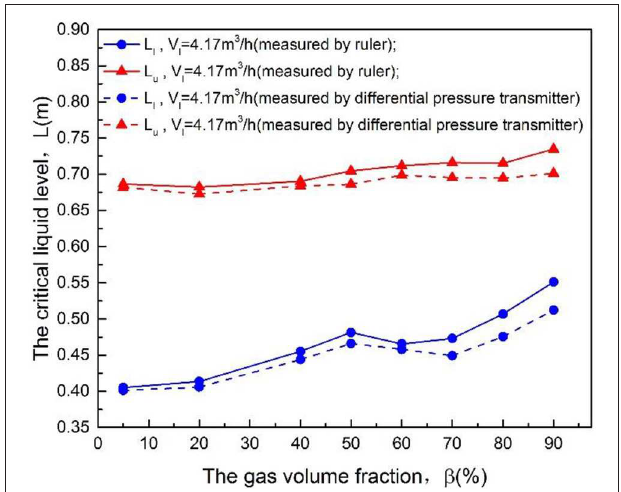
FIGURE 8 | The comparison of critical liquid levels measured by ruler and differential pressure